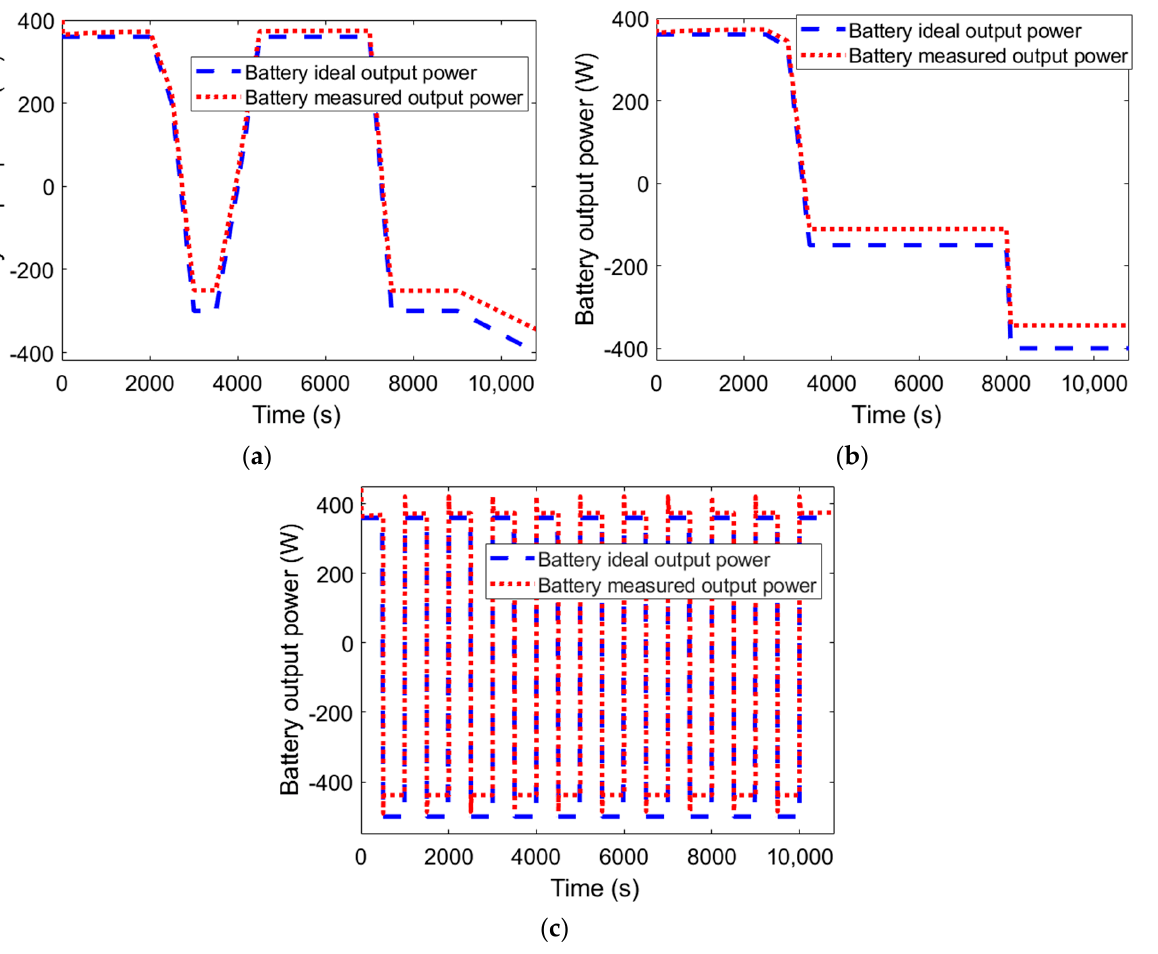
Figure 5. The load profiles of the output power of the battery in the suggested integrated system of the UAV: ( a ) case 1, ( b ) case 2, and ( c ) case 3.